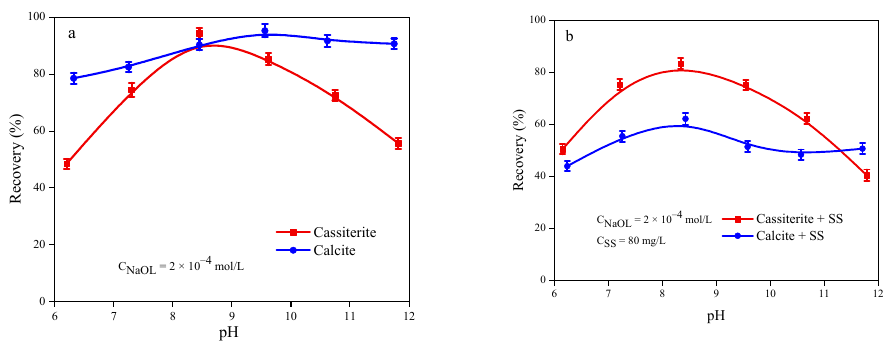
Figure 3. Flotation recovery of cassiterite and calcite in the presence of NaOL ( a ) and SS ( b ). Al 3 (SO 4 ) 2 is a common flotation reagent, which is used as regulator or flocculant. The flotation recovery of cassiterite and calcite in the presence of Al 3+ is shown in Figure 4. As shown in Figure 4, with the addition of Al 3+ , both the flotation recoveries of cassiterite and calcite decrease to a certain extent, and the recovery of calcite decreases more obviously. This may be because the added aluminum ions will combine with the collector sodium oleate to form aluminum oleate, which consumes part of the collector. However, overall, under the action of aluminum ions, the recovery rate of calcite is still very high between 60% and 80%. It is obvious that the flotation separation of cassiterite and calcite is still not feasible in the presence of Al 3 (SO 4 ) 2 .